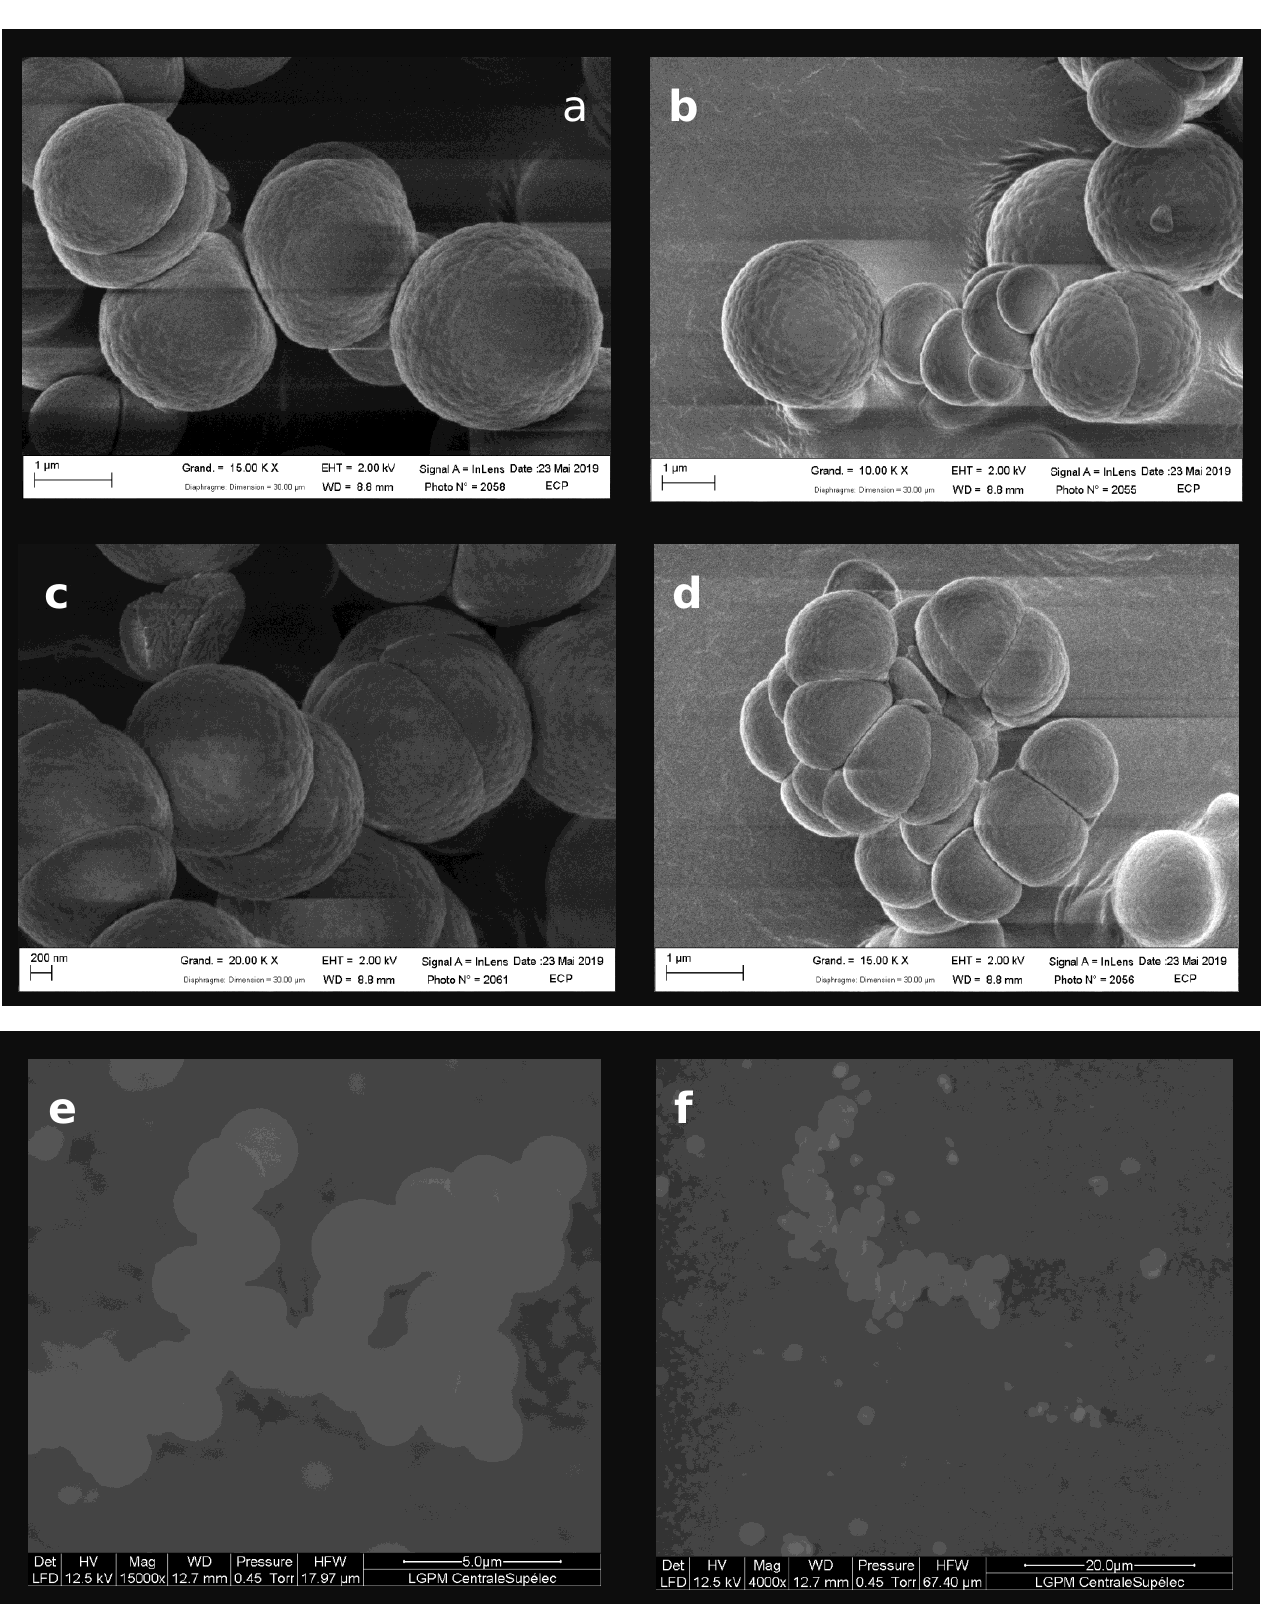
Figure 1. Morphologies of Titan’s tholins obtained with a FEG SEM for the images ( a – d ), and an environment SEM for the images ( e , f ), at different magnifications. ( a , b ) show spherical monomers formed from the coagulation of primary monomers (evolution of aggregate). ( c , d ) present aggregated monomers. ( e , f ) show agglomerates of spherical grains and aggregates.